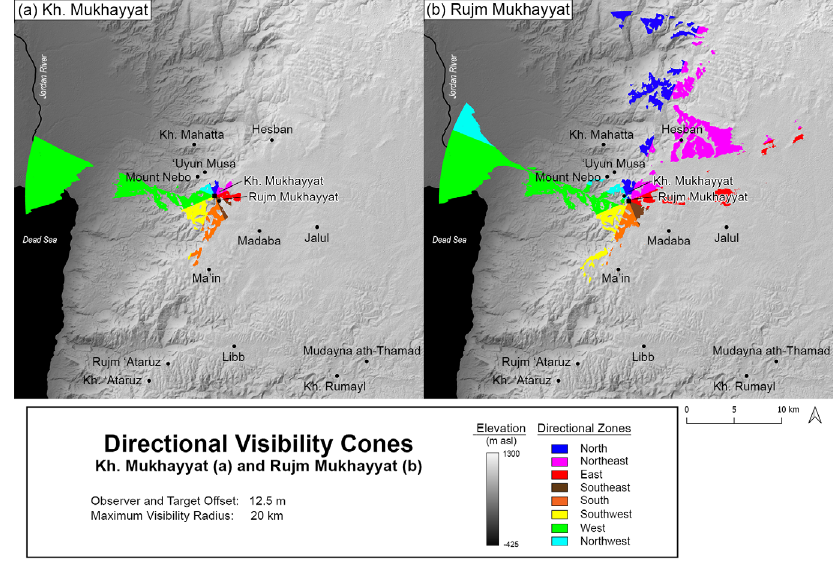
Figure 7: Comparative viewsheds of Kh. Mukhayyat (a) and Rujm Mukhayyat (b), as measured from the maximum observer/ target offset of 12.5 m, with a maximum search radius of 20 km. Visible regions are indicated by the colored regions, whose distinctive colors correspond to their respective visibility